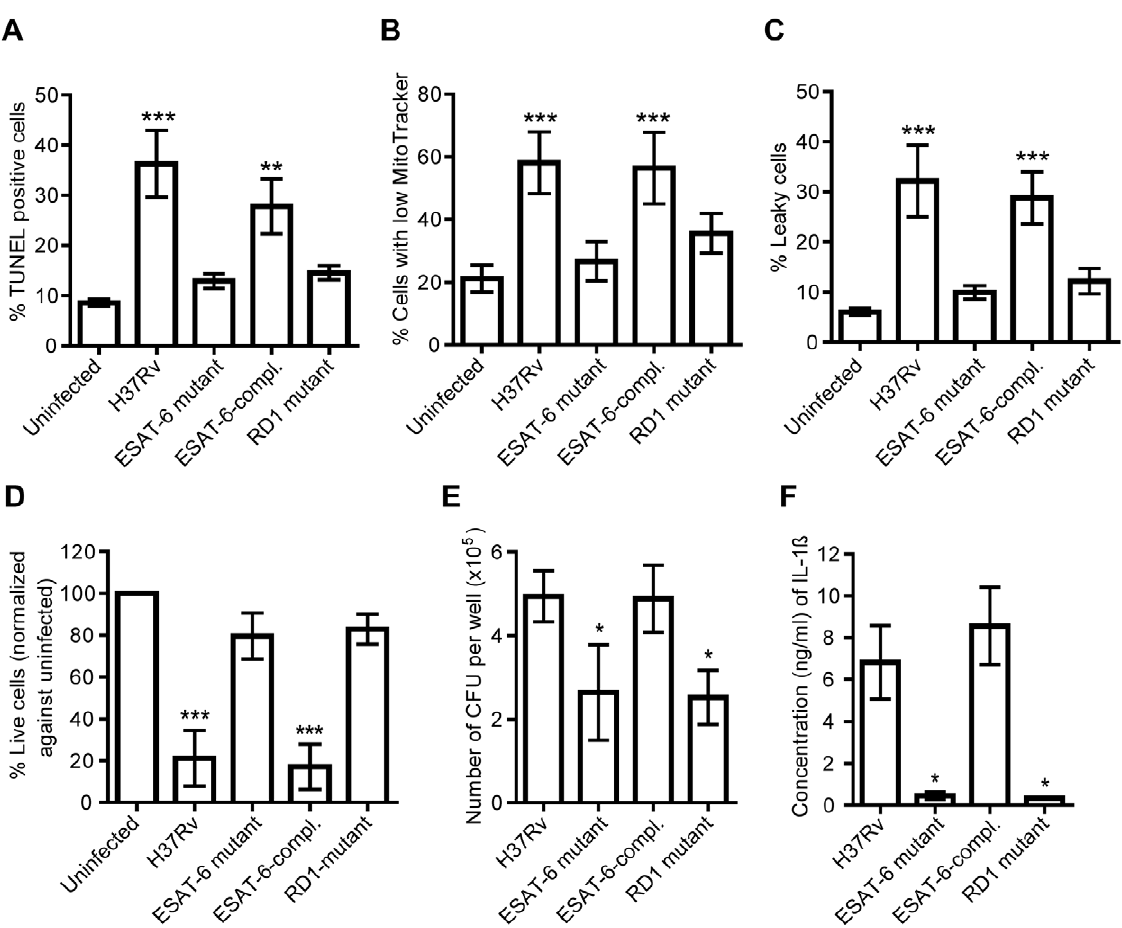
Figure 5. The role of ESAT-6 in macrophage necrosis. hMDMs were left uninfected or infected at the indicated MOI with H37Rv, an ESAT-6 mutant, a complemented ESAT-6 mutant (ESAT-6-compl.), or an RD1 mutant, and cell death was assessed by the three different staining kits after two days, and analyzed by flow cytometry, or by calcein staining. Alternatively, infected cells were lysed, dilutions were plated for viable count, and the number of CFU was enumerated. Cell culture supernatants were collected and IL-1 b was assayed by ELISA. A ) TUNEL analysis of DNA fragmentation after infection at MOI 10 (n=6). B ) MitoTracker analysis of mitochondrial membrane potential loss after infection at MOI 10 (n=6). C ) Plasma membrane integrity analysis after infection at MOI 10 (n=6). D ) Relative viability of hMDMs infected for two days with the different strains at MOI 40, as analyzed by calcein staining (n=4). The values were normalized against uninfected controls from the same reading, which were set to 100%. E ) The number of CFU per well after infection with the different strains at MOI 10 for two days, as determined by viable count analysis (n=5). F ) IL-1 b concentration in cell culture supernatants from hMDMs infected for two days with the different strains at MOI 10 (n=3). Bar graphs show the mean and SEM. The means were compared to that of uninfected hMDMs (A-D) or H37Rv-infected hMDMs (E-F) using ANOVA with Dunnett’s post-hoc test. A statistically significant difference is denoted by *(p , 0.05), **(p , 0.01), or ***(p , 0.001).